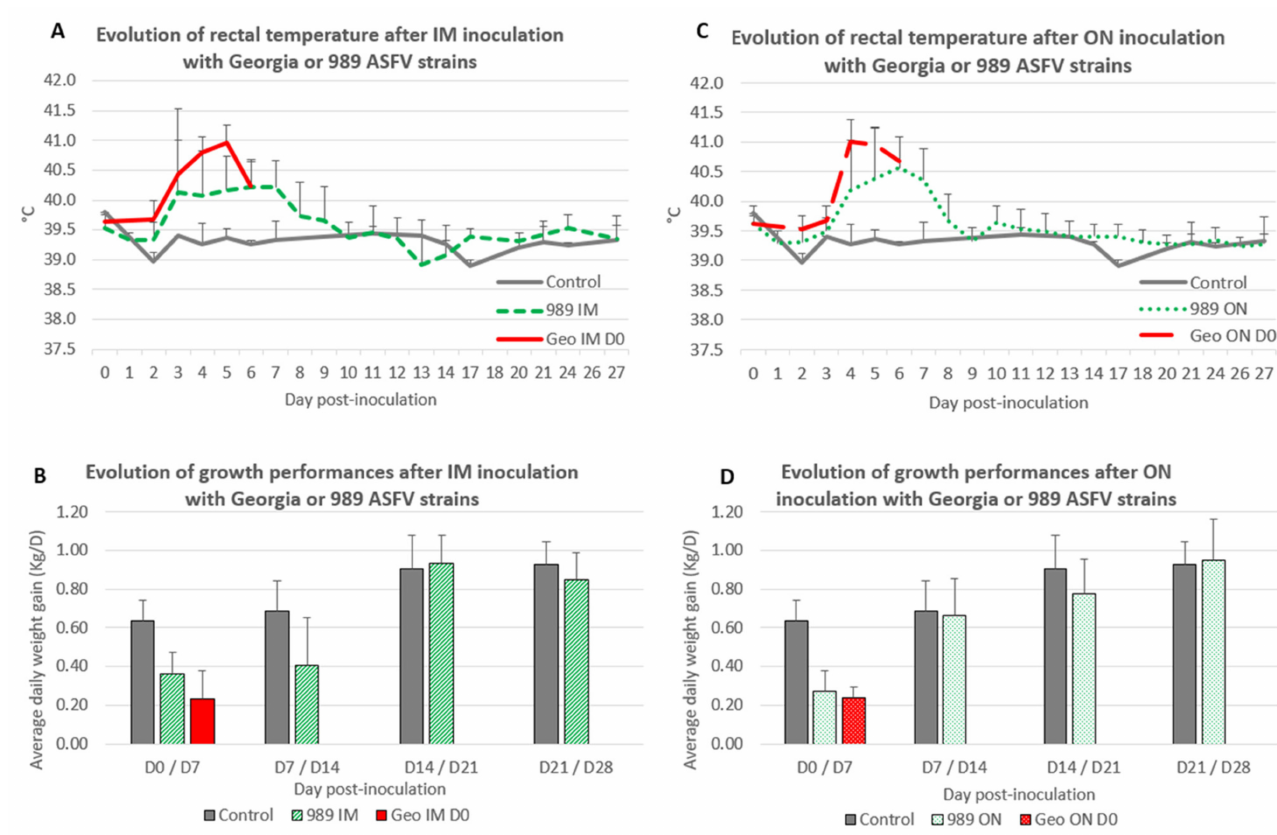
Figure 3. Evolution of rectal temperature and growth performances after Georgia or ASFV-989 strain inoculation. ( A ) Evolution of rectal temperature ( ◦ C) after IM inoculation with Georgia or ASFV-989 strains (time in days post-inoculation). Control—data from group A1; 989 IM—data from groups C and D; Geo IM—data from group E that were euthanized/died at 6 dpi. ( B ) Evolution of growth performances: average daily weight gain (Kg/D) after IM inoculation with Georgia or ASFV- 989 strains (time in days post-inoculation). Control—data from groups A1 and A2; 989 IM—data from groups C and D; Geo IM—data from group E. ( C ) Evolution of rectal temperature ( ◦ C) after ON inoculation with Georgia or ASFV-989 strains (time in days post-inoculation). Control—data from group A1; 989 ON—data from groups B, H, and I; Geo ON—data from group F that were euthanized/died at 6 dpi. ( D ) Evolution of growth performances: average daily weight gain (Kg/D) after ON inoculation with Georgia or ASFV-989 strains (time in days post-inoculation). Control—data from group A1 and A2; 989 ON—data from groups B, H, and I; Geo ON—data from group